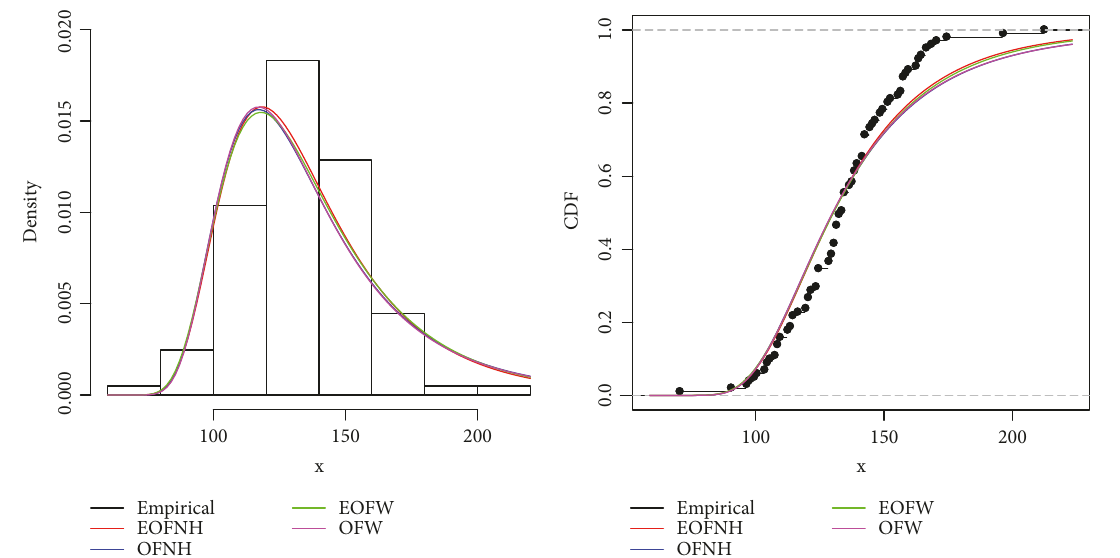
Figure 5: Plots of histogram of data and fitted densities; and empirical CDF and fitted CDF.